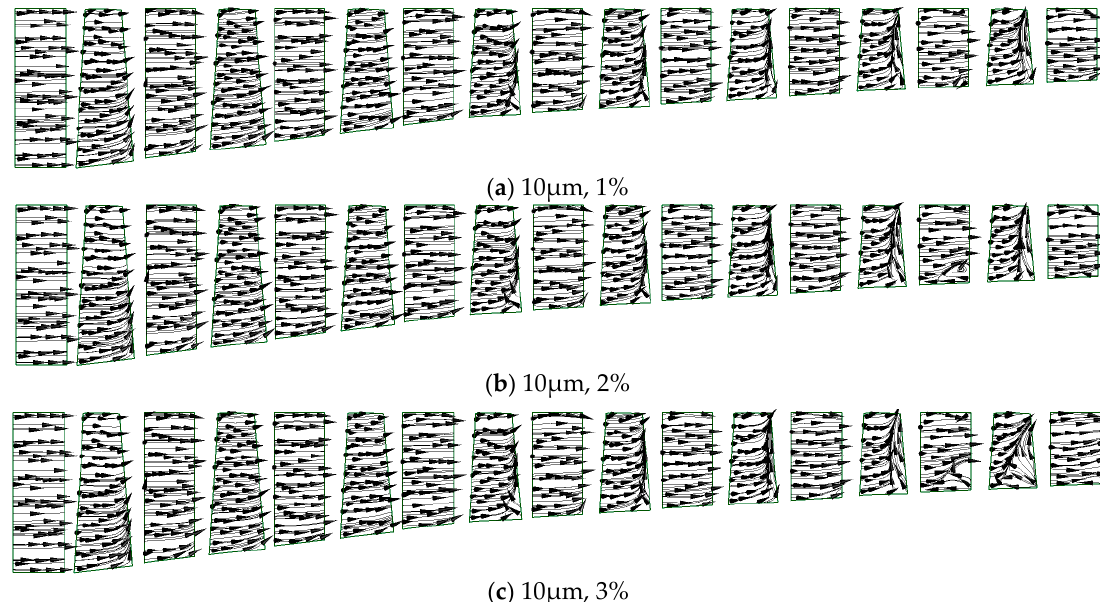
Figure 24. Limiting streamlines on suction surfaces of the compressor blades under water of different injecting rates.